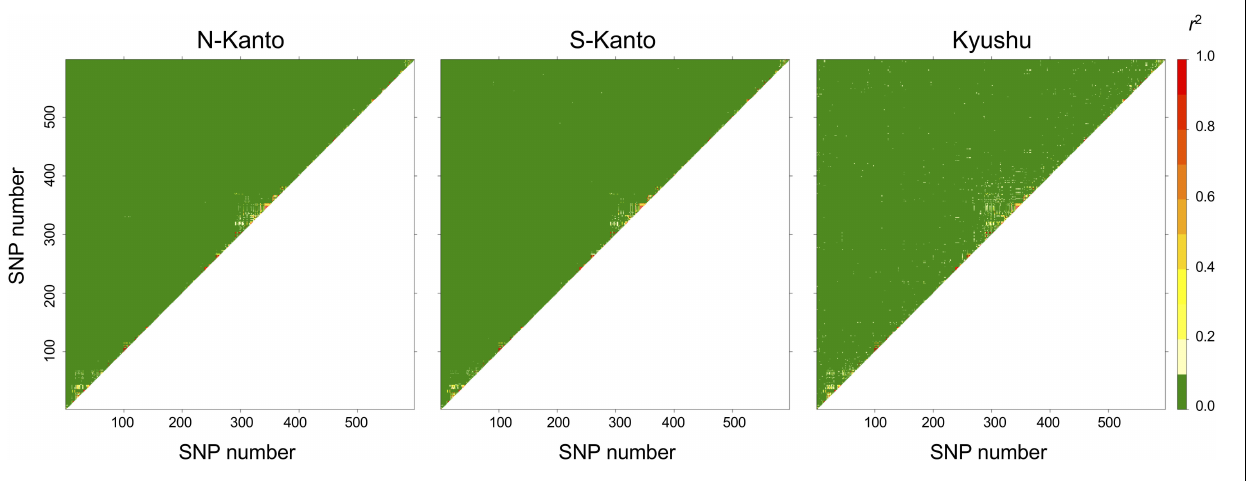
FIGURE 2 | Linkage disequilibrium (LD) between pairs of SNPs as heat map in